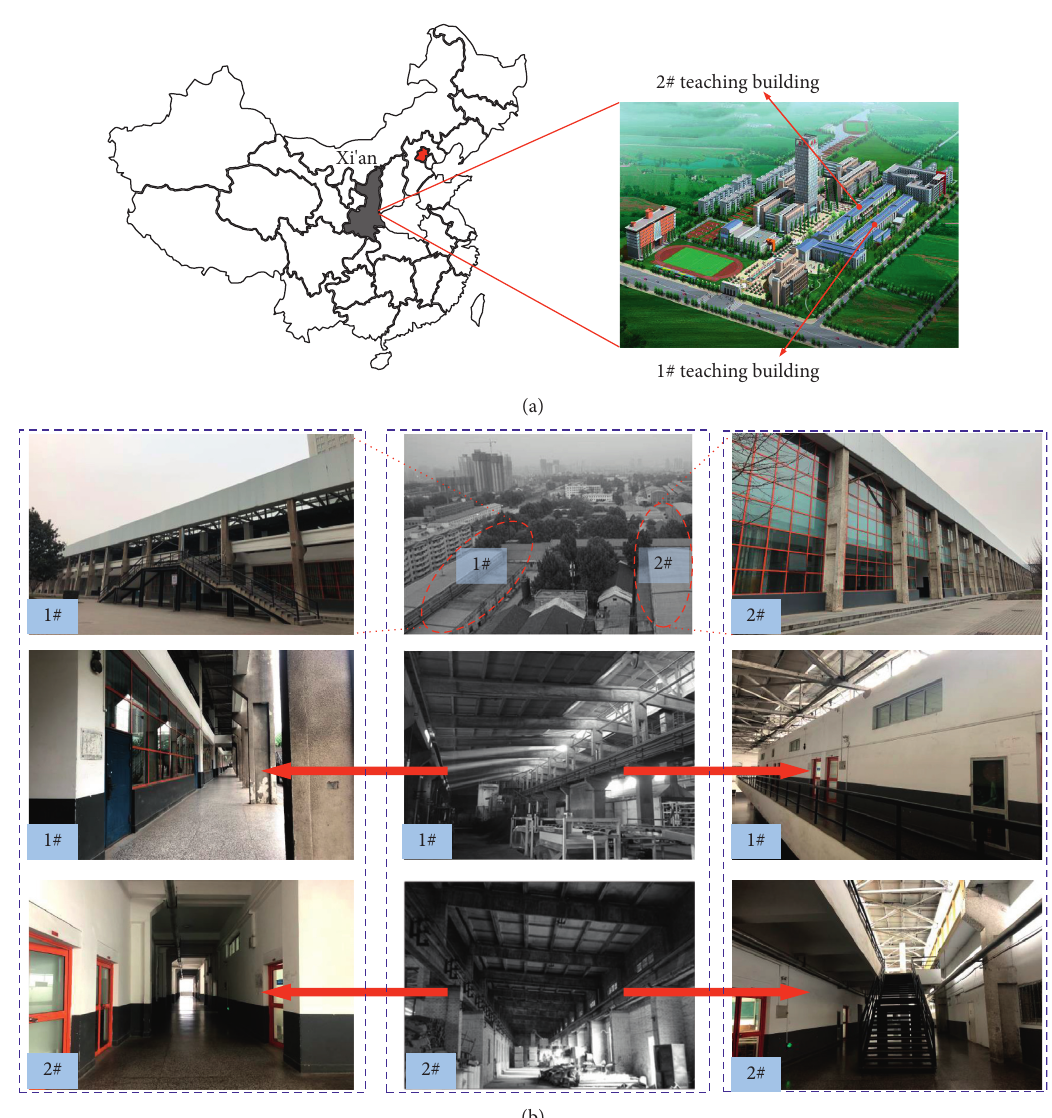
Figure 3: Location and details of teaching building (before and after). (a) Location of 1# and 2# teaching buildings. (b) Images of 1# and 2# teaching buildings (before and after).